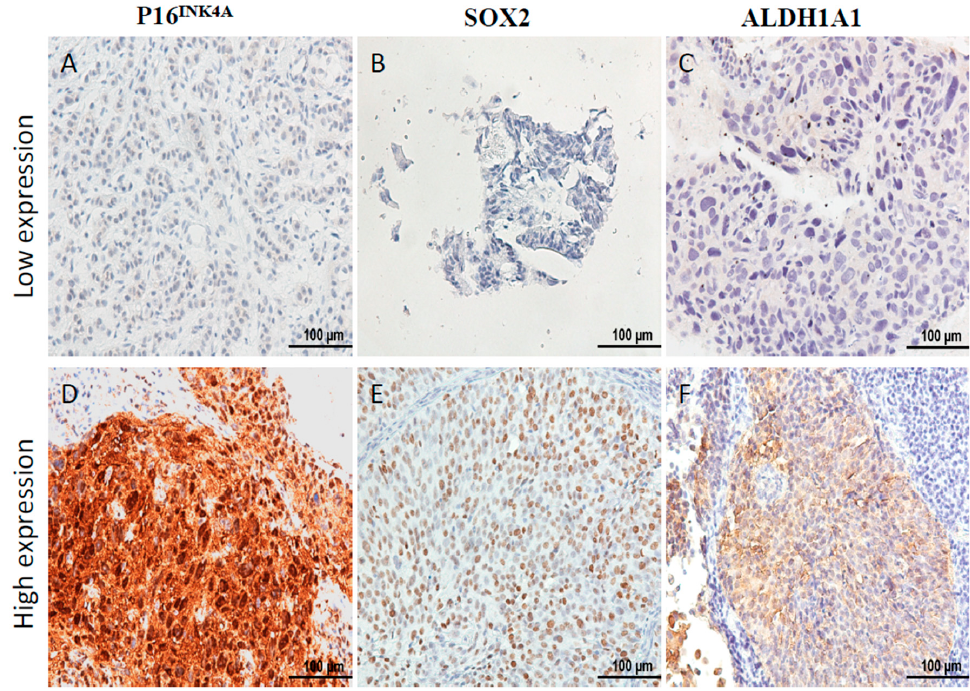
Figure 2. Immunostaining of P16 INK4A , SOX2, and ALDH1A1 expression in pretreatment cervical cancer. Immunohistochemical staining of P16 INK4A expression was low in ( A ) and high in ( D ), SOX2 expression was low in ( B ) and high in ( E ), and ALDH1A1 expression was low in ( C ) and high in ( F ). Scale bar: 100 μ m. Table 1. Patient characteristics.